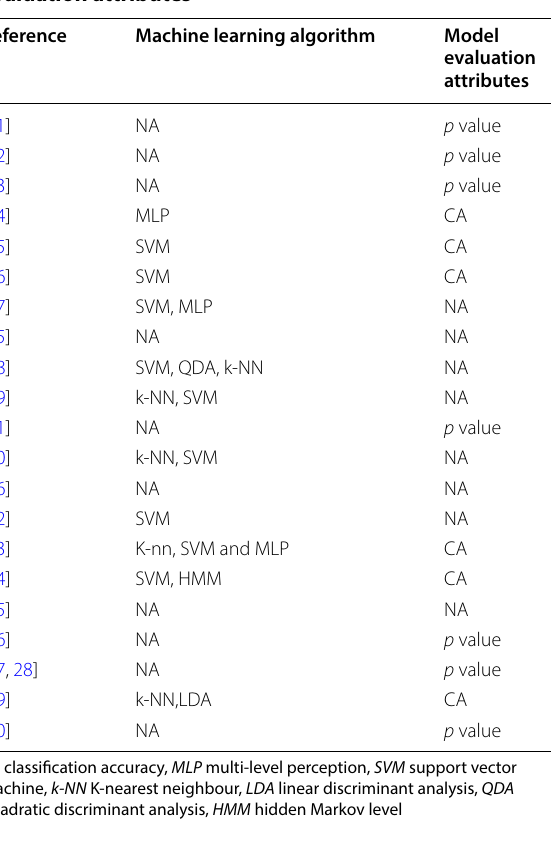
Table 7 Brainwave, location investigated and statistical test